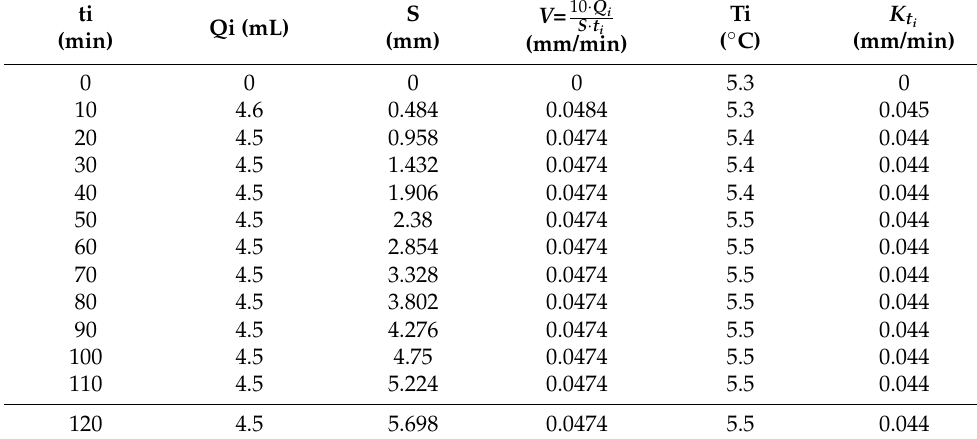
Table 1. Soil permeability record.